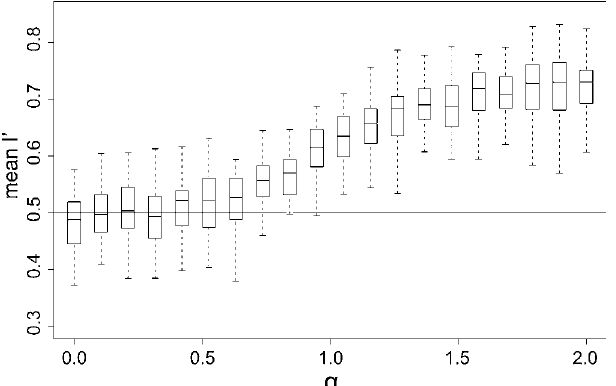
Figure 1. TheEffectofFertilityInheritanceontheBalanceMeasureMean I 9 For each value of the fertility inheritance parameter a , 100 coalescent trees with 100 individuals were simulated. The extremities of the boxes correspond to the first and the third quartiles. The horizontal line in each box represents the median, and the whiskers extend to the most extreme data points. The horizontal line indicates 0.5, the expected value of mean I 9 under the neutral coalescent. DOI: